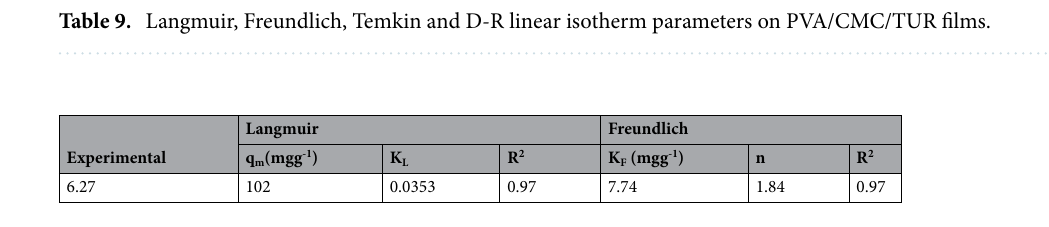
Table 10. Langmuir and Freundlich non-linear isotherm parameters on PVA/CMC/TUR films.